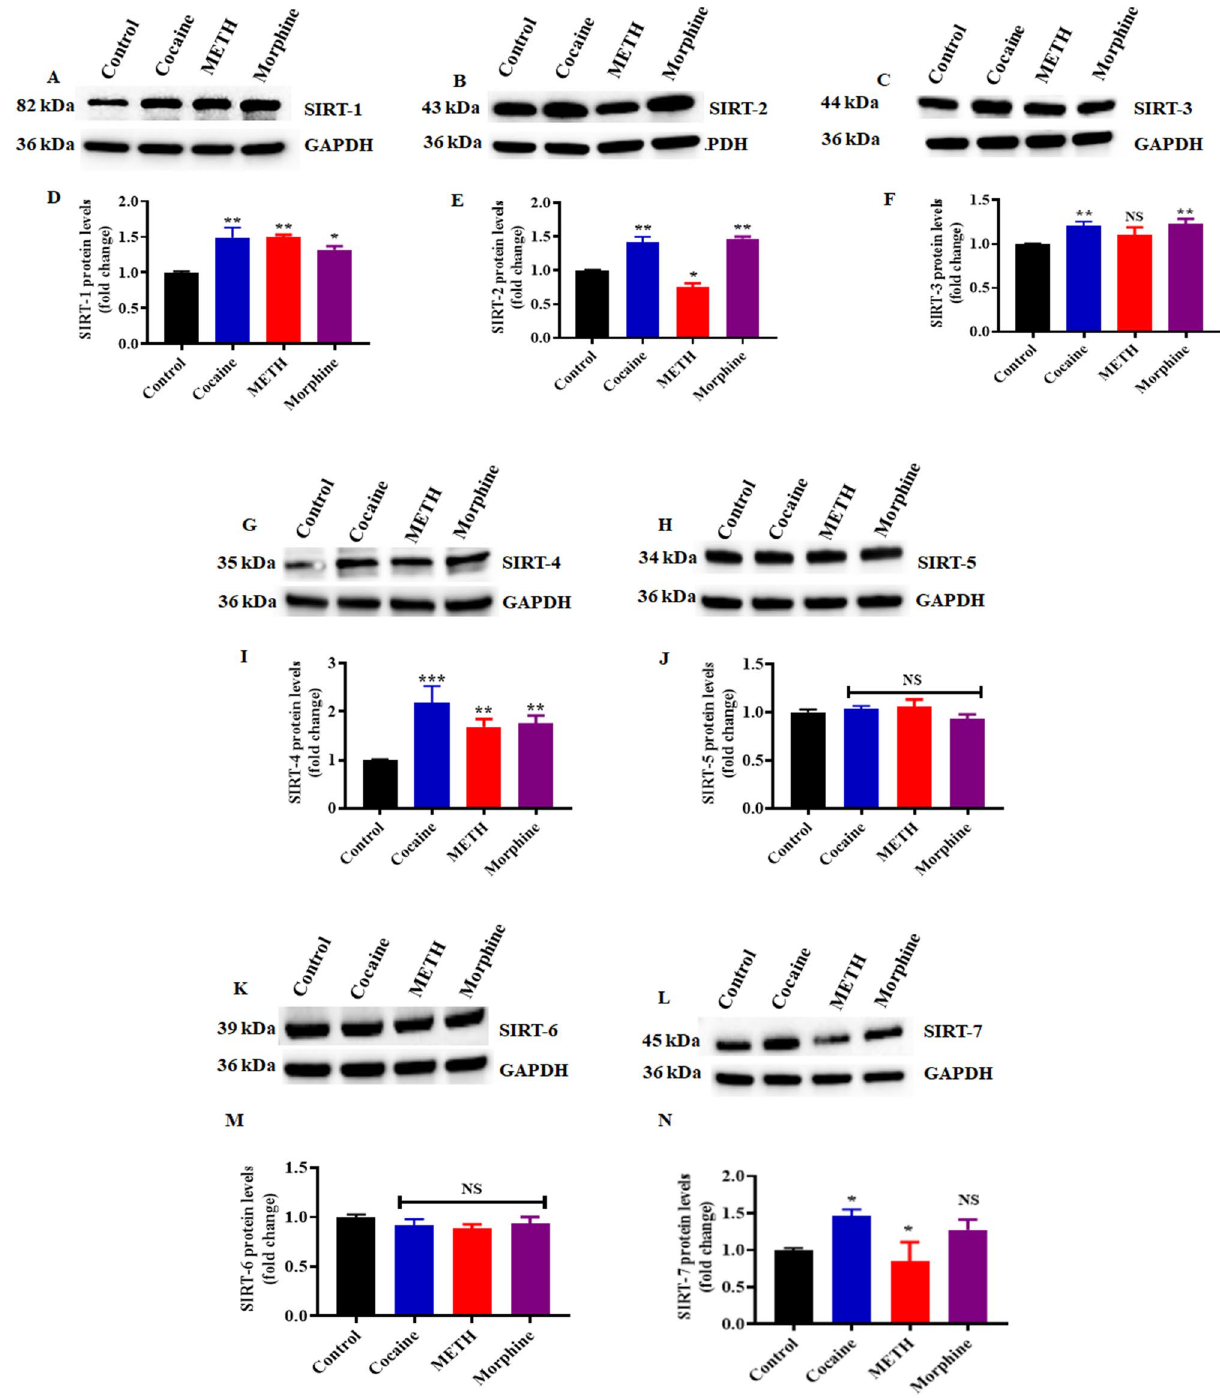
Figure 1. Effects of psychostimulants and opioids on SIRTs (1–7) in human primary astrocytes. Cells were exposed to cocaine (1 µM), METH (10 µM) and morphine (5 µM) for 24 h. The protein expression levels of different classes of SIRTs (1–7) in astrocytes were determined using Western blotting analysis with GAPDH as a loading control. Western blot showing ( A ) SIRT-1, ( B ) SIRT-2, ( C ) SIRT-3, ( G ) SIRT-4, ( H ) SIRT-5, ( K ) SIRT-6 and ( L ) SIRT-7. Densitometric analyses ( D – F , I , J , M , N ) represent the protein levels (fold-change from control). The data are expressed as the means ± SD of three independent experiments. ***P < 0.001, **P < 0.01, *P < 0.05, NS—Nonsignificant. Treatments groups were compared to Control. The supplementary information includes all full-length